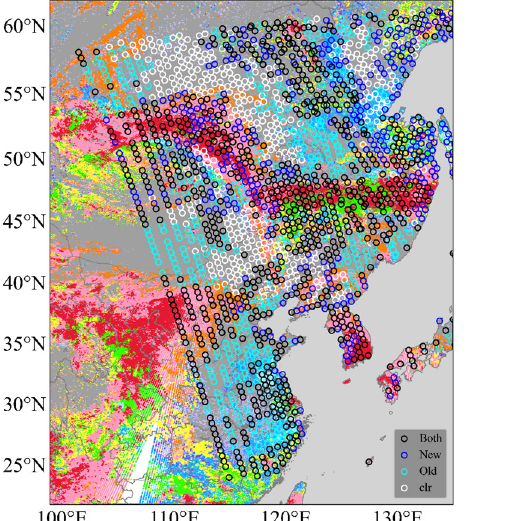
Figure 9. Distribution of data volume in di ff erent O − B intervals (interval: 1 K) before (left-hand side) and after (right-hand side) removal of cloudy observations for AMSU-A channels 1–6 and 15 from NOAA-19 from June to August 2019, with the colors representing the data volume.